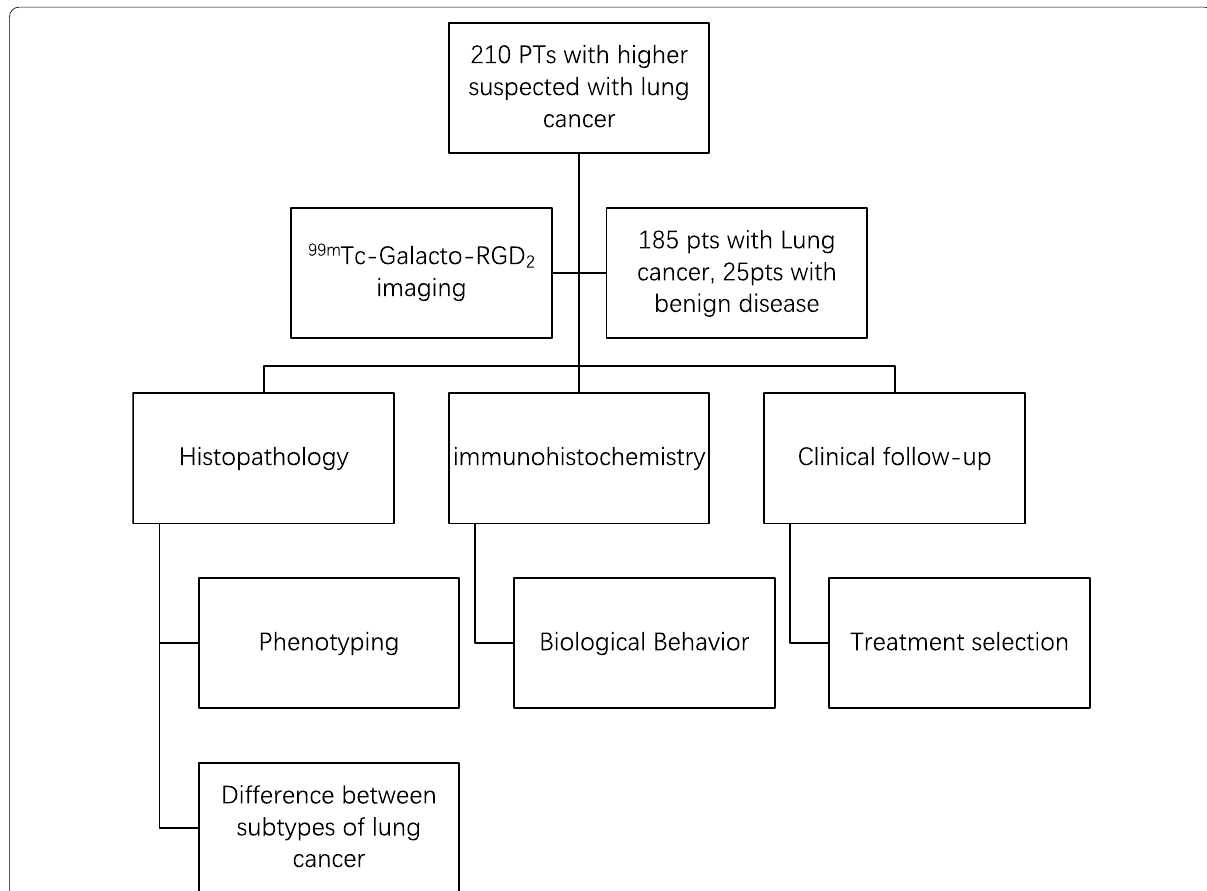
Fig. 1 The study flow for the [ 99m Tc]Tc-Galacto-RGD 2 imaging in the diagnosis of lung